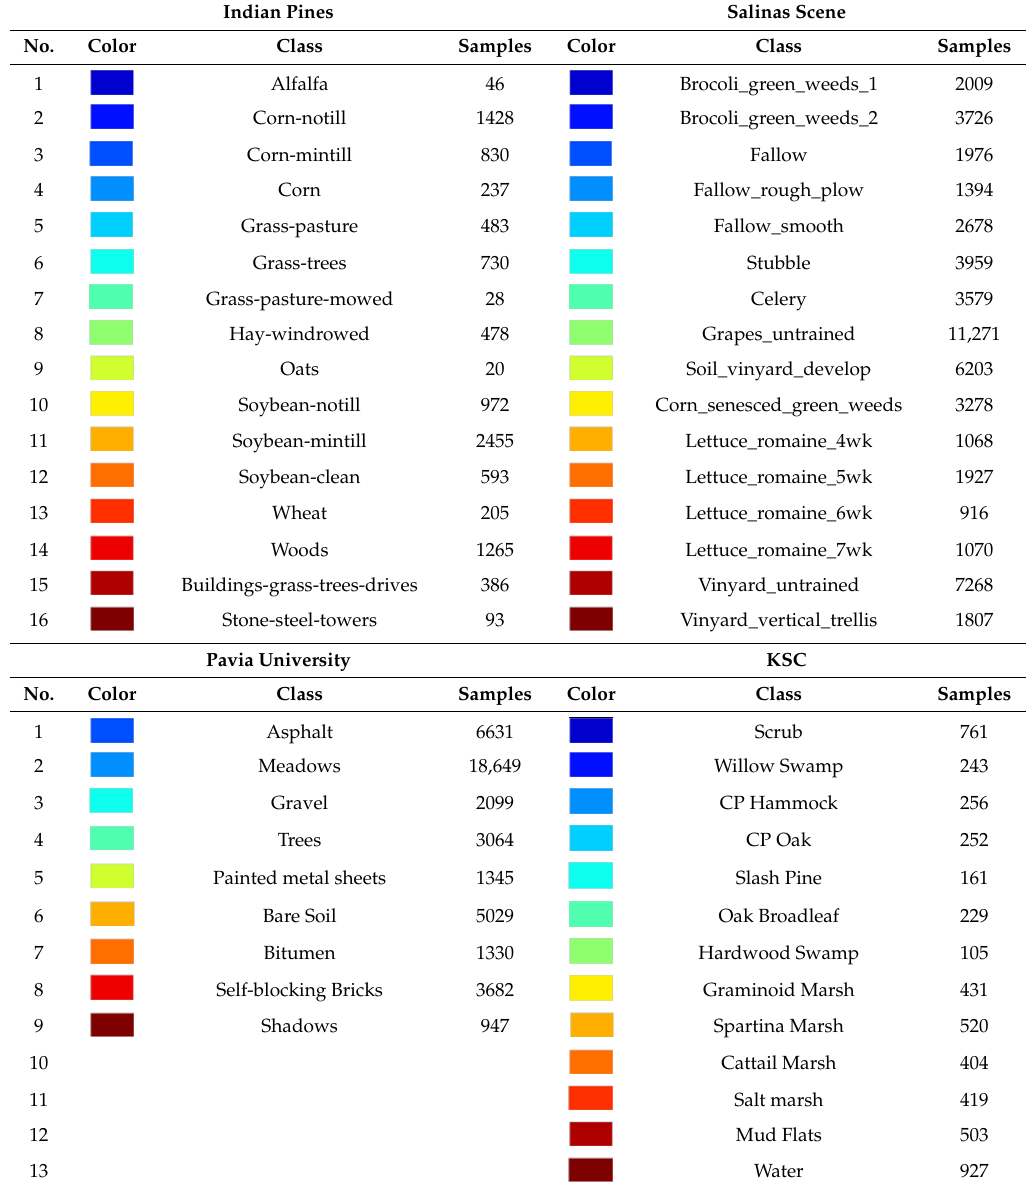
Table 1. Information regarding samples of each class in four data sets.